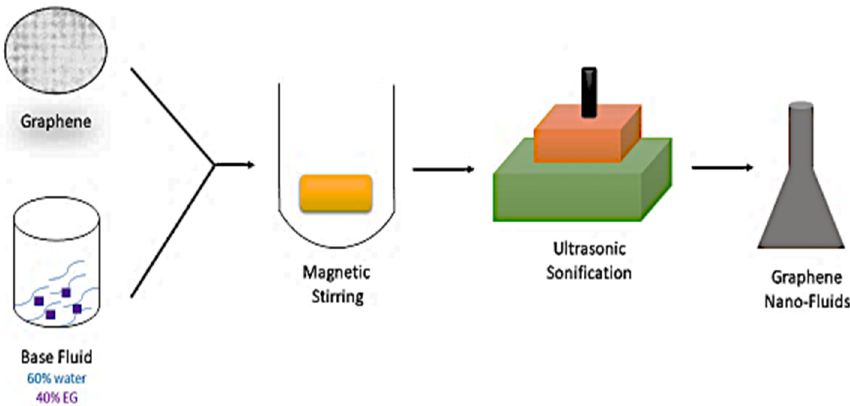
Figure 2. Graphene nanofluids preparation process.